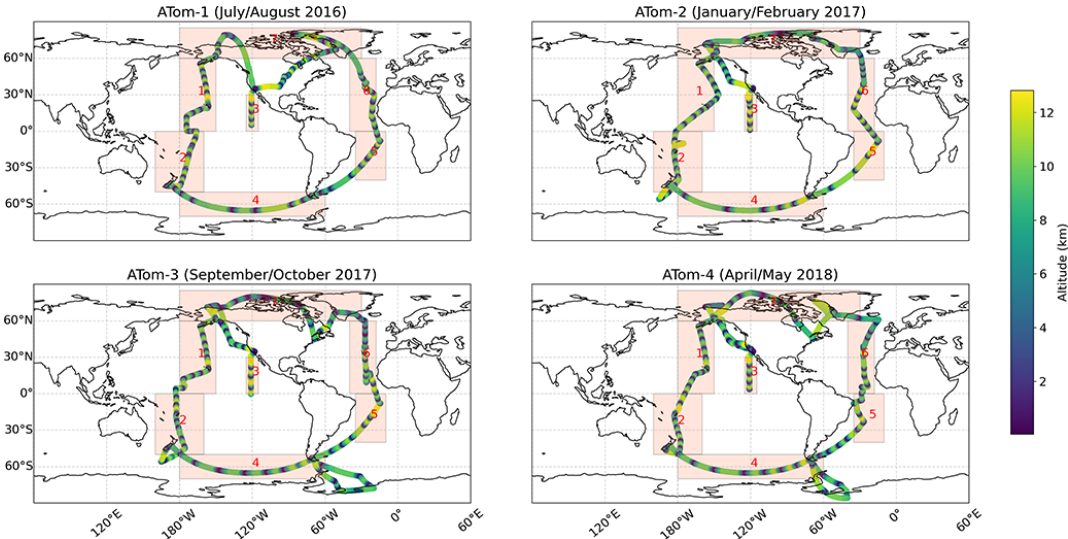
Figure 2. Flight paths of the four ATom campaigns. The respective altitude is coloured, and the paths are sub-divided into seven different remote regions, namely the Northwest Pacific (1), Southwest Pacific (2), East Pacific (3), Southern Ocean (4), South Atlantic (5), North Atlantic (6), and North Canada/Alaska/Greenland